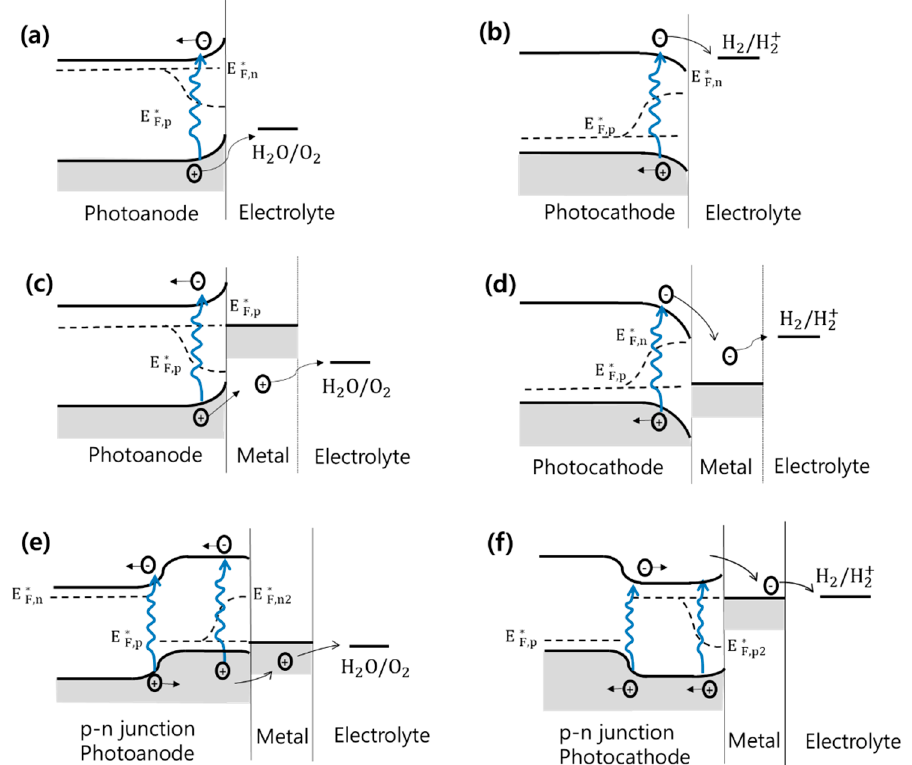
Figure 5. Examples of silicon-based PEC half-cell configurations under illumination. ( a ) n- type Si photoanode, ( b ) p- type Si photocathode. ( c ) Photoanode with a catalyst layer on the surface, metal/n-